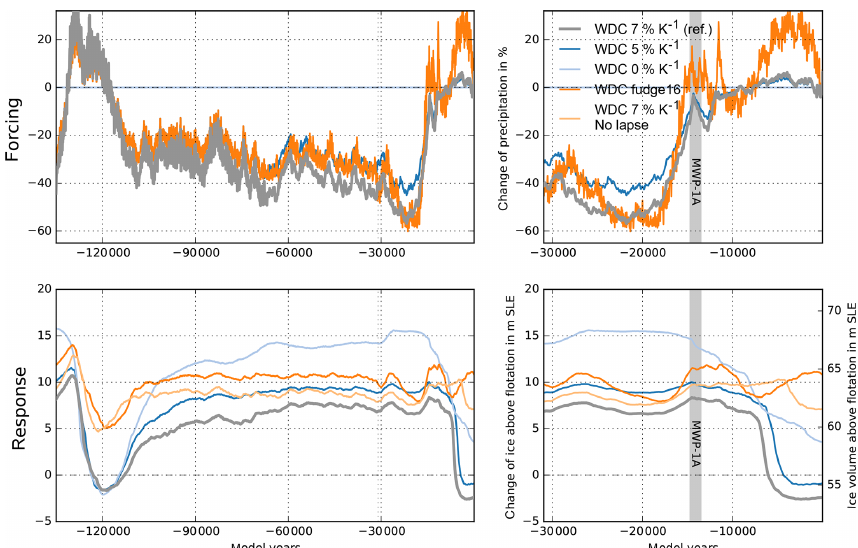
Figure 23. Sensitivity of transient ice volume above flotation to varied precipitation forcing. Grey curve is the reference, with an exponential scaling factor of 7%K − 1 with respect to WDC temperature reconstruction (Cuffey et al., 2016). Ice volume is slightly larger for 5%K − 1 (blue) and much larger without precipitation forcing (light blue). Deglaciation is prohibited when using WDC accumulation reconstruction (Fudge et al., 2016) with additional accumulation during Holocene (orange). A similar effect is seen when no lapse-rate correction is applied for the precipitation (light